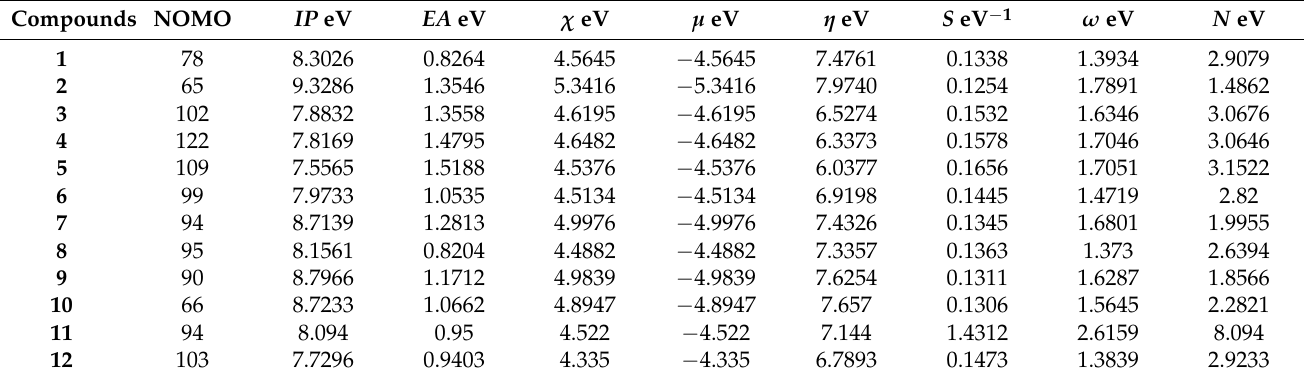
Table 1. Calculated number of occupied molecular orbitals (NOMO), IP, EA , µ , χ , η , S , ω , and index N for 1 – 12 at the B3LYP/6-311 G (d, p)